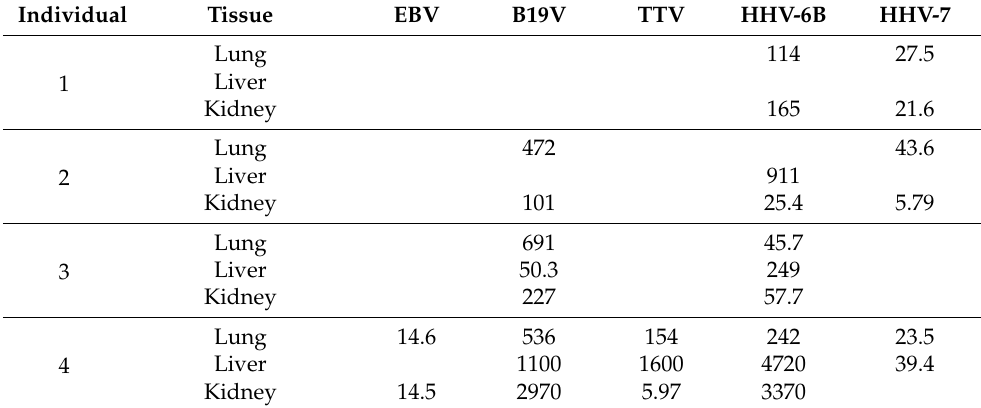
Table 1. Distribution and viral copies/million cells in the frozen